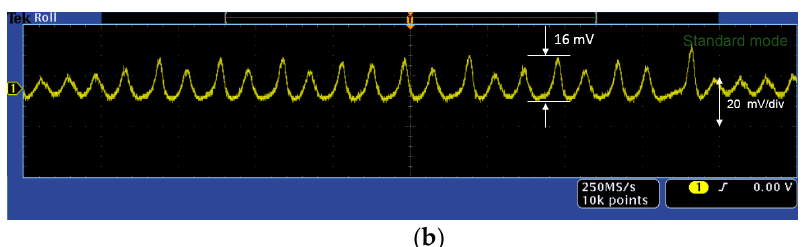
Figure 21. Measurement of output voltage ripple: ( a ) Chaotic mode and ( b ) Fixed-frequency mode (Measurement Mode: AC coupling @ DC level: 0 V).